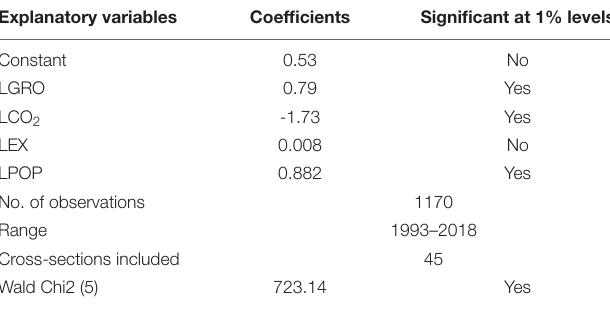
TABLE 6 | Estimation results for 45 Asian countries.